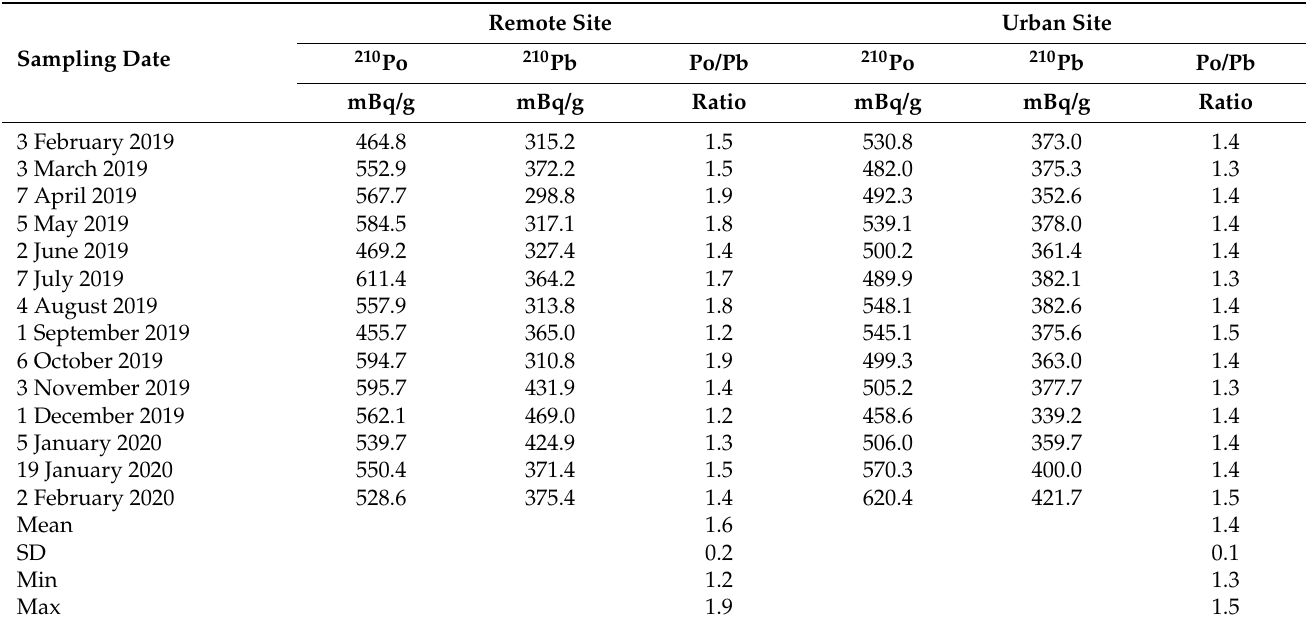
Table 5. Polonium/lead ( 210 Po/ 210 Pb) activity concentrations (mBq/g) and activity concentration ratios in the total aerosol samples collected at two sampling